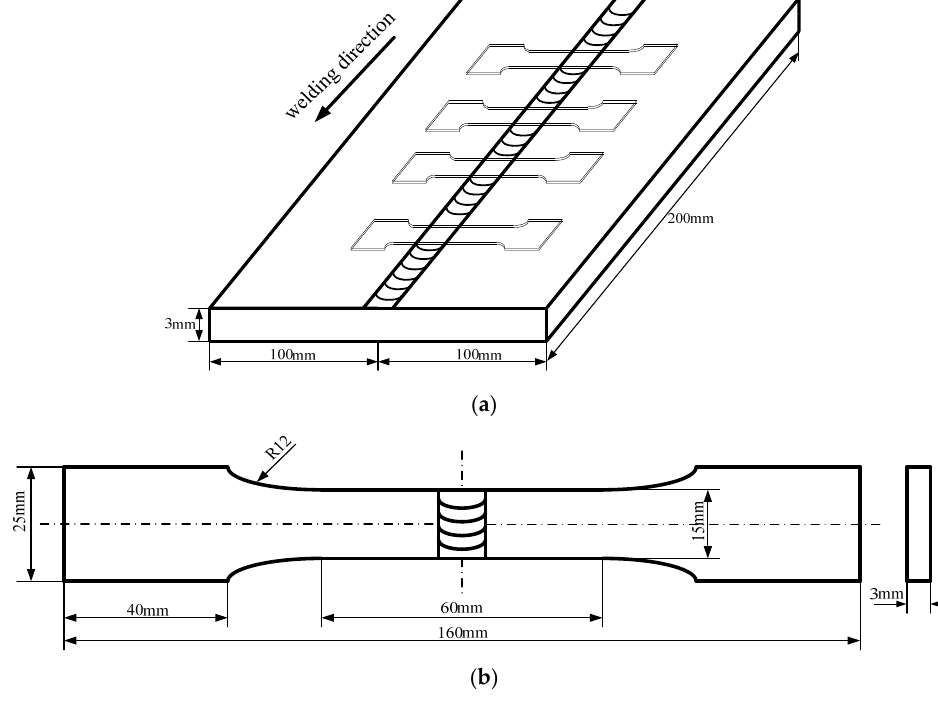
Figure 2. Dimensions of tensile specimens: ( a ) Schematic diagram of welding regarding to rolling direction and extraction of tensile specimens; ( b ) Dimensions of flat smooth tensile specimen.